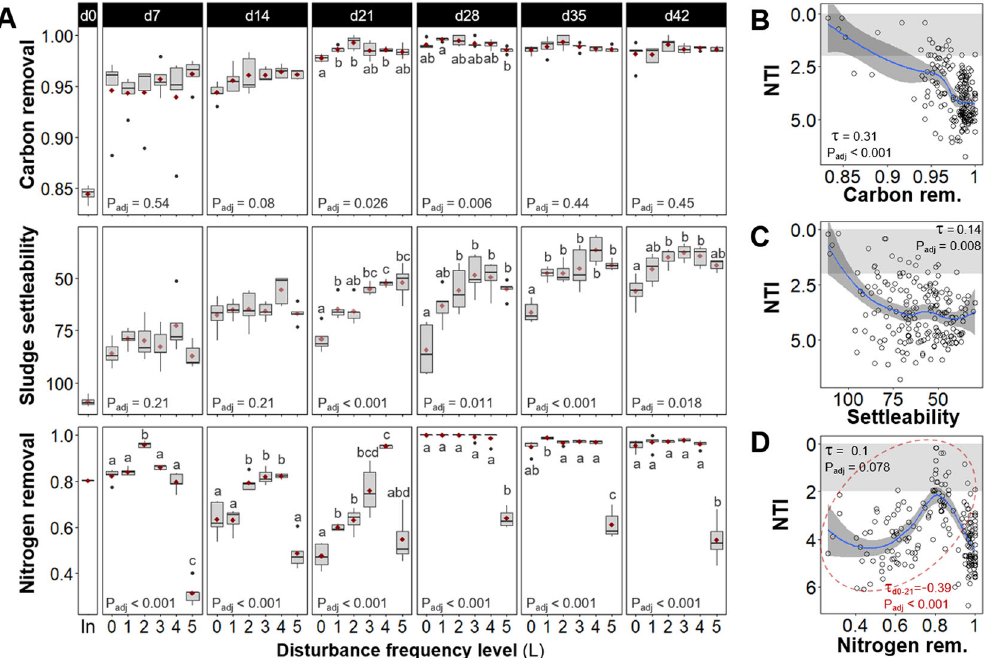
Fig. 3 Community function dynamics. A Community function assessed via in fl uent chemical oxygen demand removal (carbon removal as fraction of total, upper panels), sludge volume index (sludge settleability, middle panels), and in fl uent total Kjeldahl nitrogen removal (nitrogen removal as fraction of total, lower panels) for different frequencies of organic loading disturbance ( n = 5). Disturbance frequency levels (L): 0 (undisturbed), 1 – 4 (intermediately disturbed), 5 (press disturbed). In: sludge inoculum (day 0, n = 4). Each panel represents a sampling day, red diamonds display mean values. The box bounds the IQR divided by the median, and Tukey-style whiskers extend to a maximum of 1.5 times the IQR beyond the box. Characters above boxes display Games-Howell post hoc grouping ( P adj < 0.05). Welch ’ s ANOVA P -values adjusted at 5% FDR shown within panels. Correlations of B carbon removal, C sludge settleability, and D nitrogen removal, vs. NTI from bacterial ASV data across all frequency levels and time points evaluated in this study ( m = 184). Kendall correlation τ - and adjusted P - values are indicated within the panels. Blue line represents locally estimated scatterplot smoothing regression (loess) with con fi dence interval in dark-gray shading. Shaded in gray is the zone of signi fi cant stochastic phylogenetic dispersion, |NTI | < 2. Red ellipse and τ - and P -value in panel D indicate data at initial stages of succession (d0 to d21). Note the inverted axis for sludge settleability, as it increases with decreasing SVI values, and for NTI, since values closer to zero indicate a higher relative contribution of stochastic